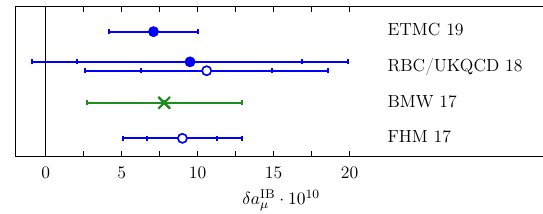
Figure 4. Compilation of recent results for the isospin-breaking correction δ a IB µ to the hadronic vacuum polarisation, determined by ETMC [48], RBC / UKQCD[49], BMW[50] and Fermi- lab / HPQCD / MILC [51]. Solid circles denote the full (strong and electromagnetic) isospin-breaking correction, while open sym- bols represent strong isospin breaking only. The result marked by the green cross is based on a phenomenological estimate.